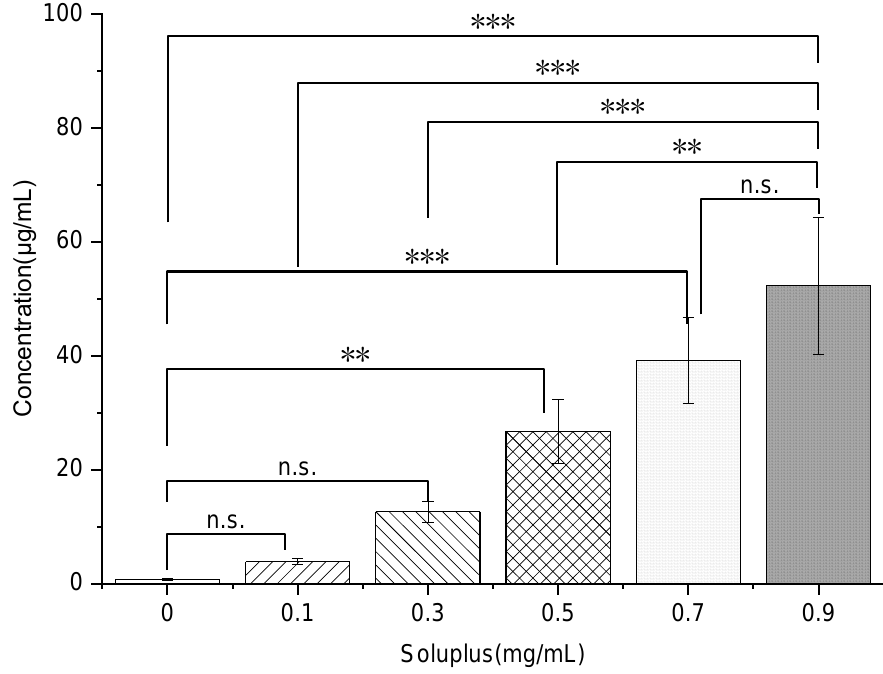
Figure 10. Phase solubility diagram of FEL in PBS (pH 6.8) mixed with the pre-dissolved polymer Soluplus ® at different concentrations (from 0.1 to 0.9 mg/mL) at 37 °C. ** p < 0.01, *** p <0.001. Standard deviation expressed by error bars (n = 3).